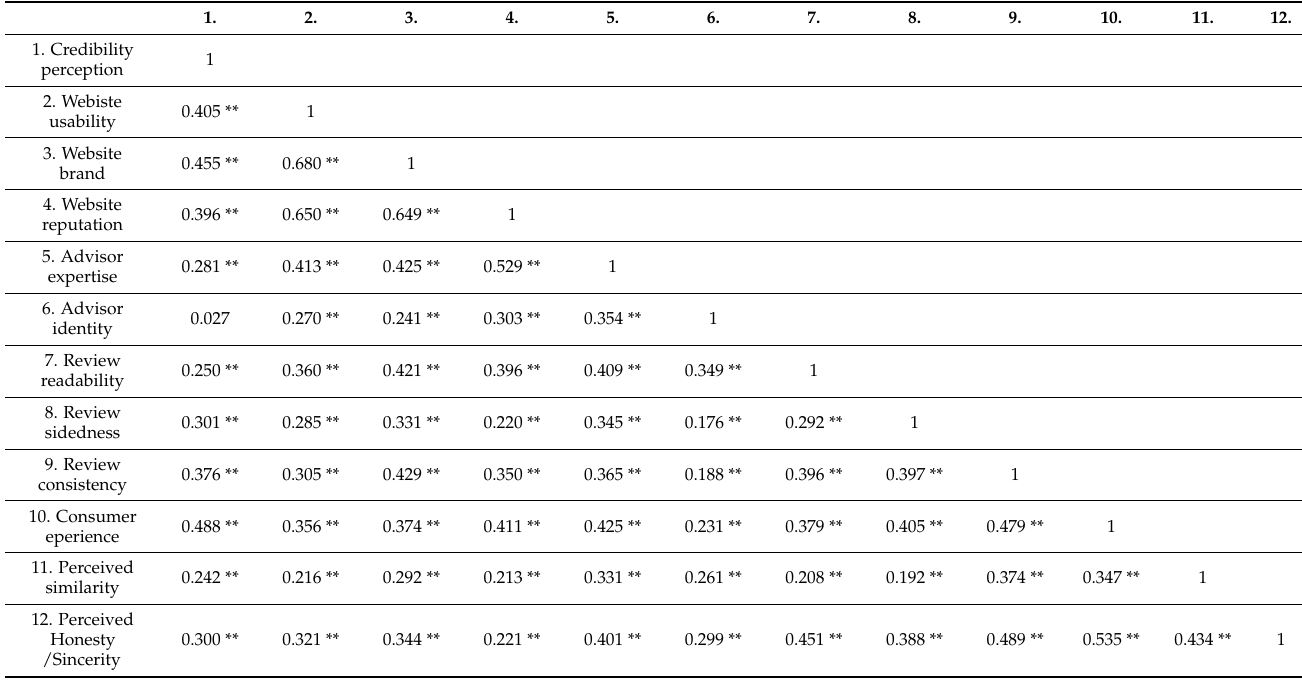
Table 2. Pearson’s correlation coefficients between model